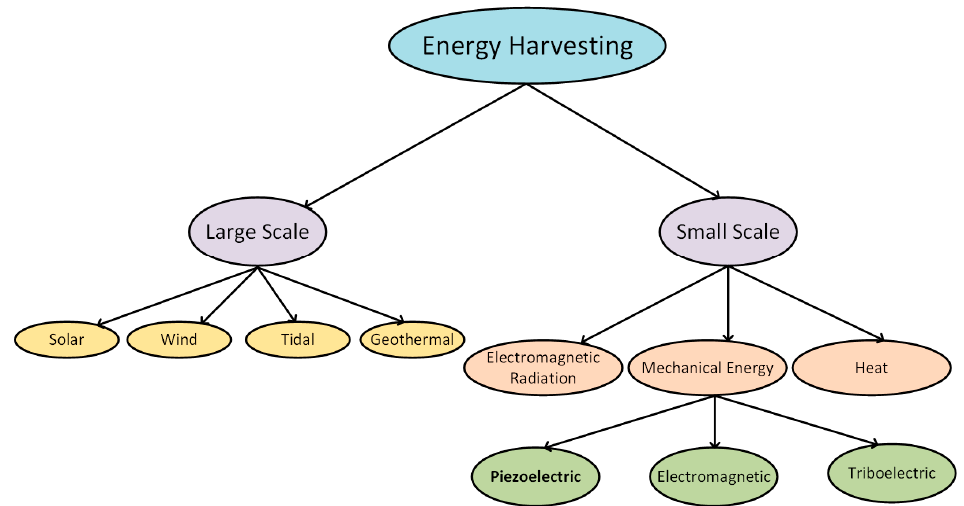
Figure 2. Classification of energy harvesting sources.